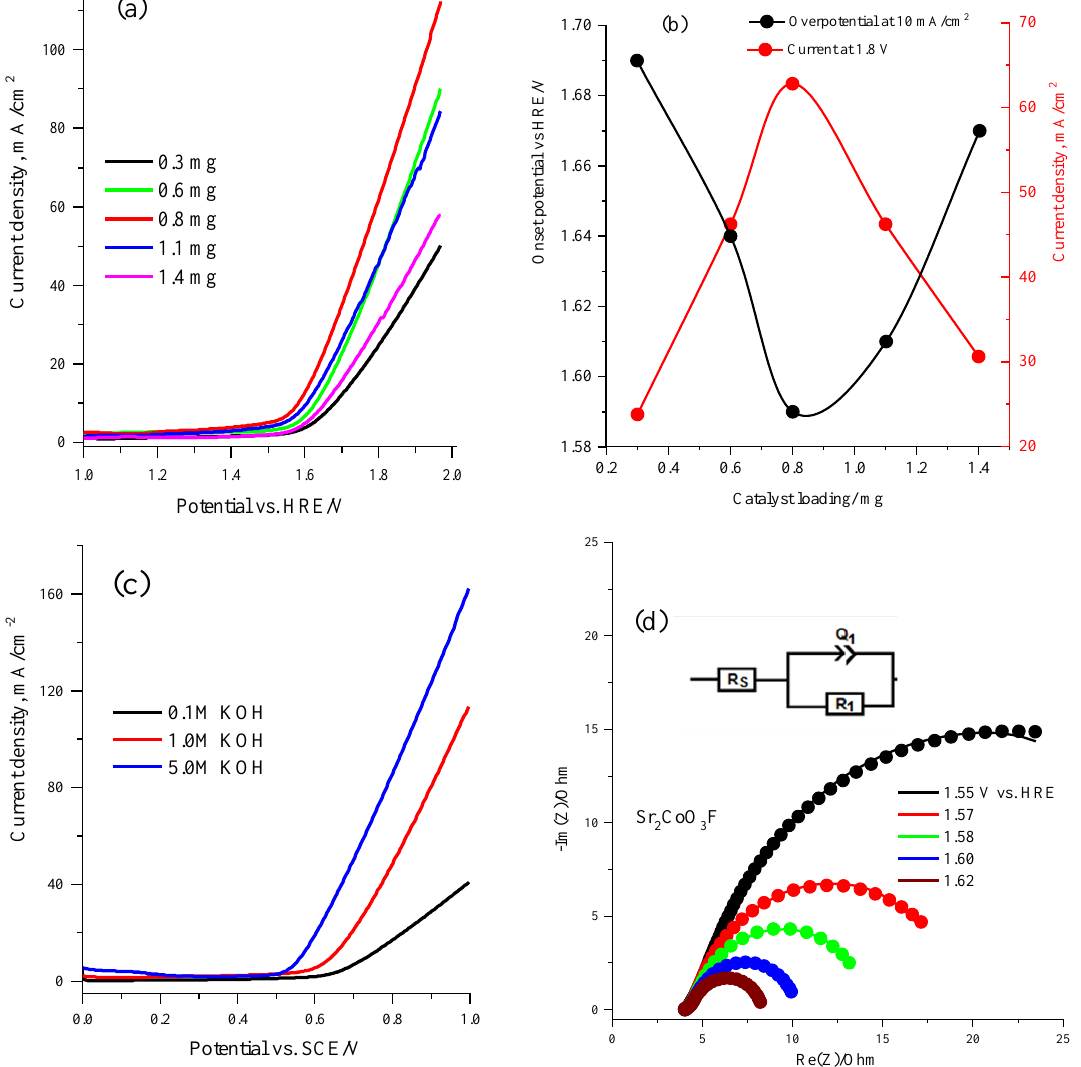
Figure 8. ( a ) LSV at 20 mVs − 1 for the Sr 2 CoO 3 F catalyst in 1.0 M NaOH electrolyte with different catalyst loading, ( b ) plot for the relation of the catalyst loading against the potential at 10 mA/cm 2 (black line) and the OER current density achieved at 1.8 V vs. HRE (red line), ( c ) the LSV at 20 mV s − 1 of the Sr 2 CoO 3 F catalyst (loading of 0.8 mg/cm 2 ) in different concentration of NaOH electrolyte, and ( d ) EIS Nyquist diagram and equivalent circuit for the Sr 2 CoO 3 F catalyst at the different applied potential within the frequency range of 0.01 to 1.0 MHz and a 20 mV amplitude and in 1.0 M NaOH solution. Table 5. Impedance parameter values derived from the fitting of the equivalent circuit for the im-